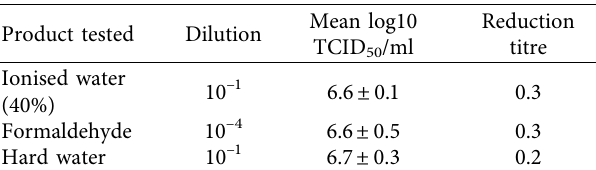
Table 2: Comparative titrations of the SARS-CoV-2 virus after treatment of VERO-81 cells with ionised water 40%, formaldehyde (0.7%), and hard